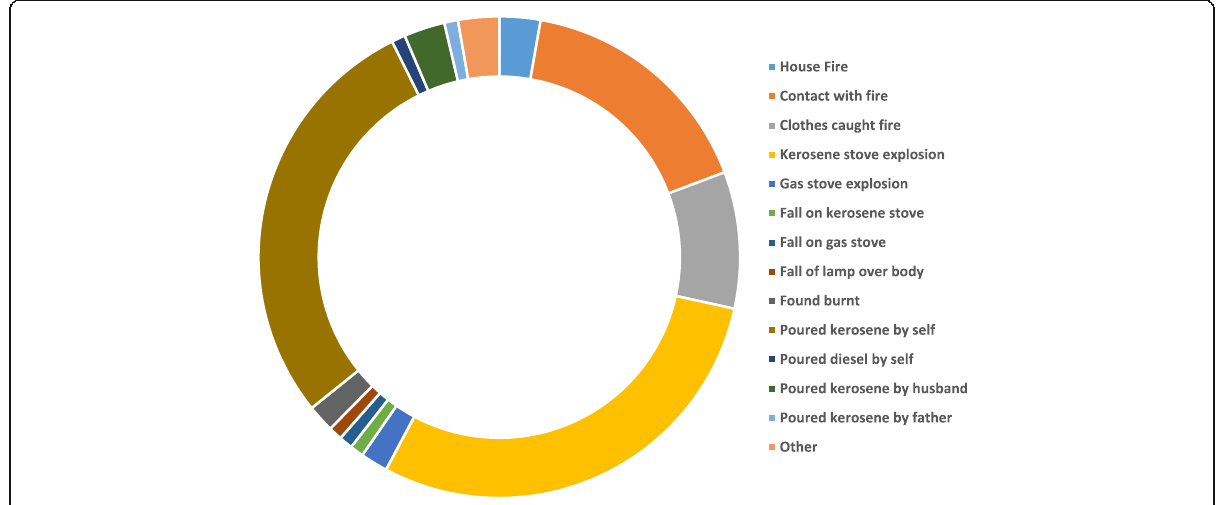
Fig. 1 Method of burn injury or source of fire